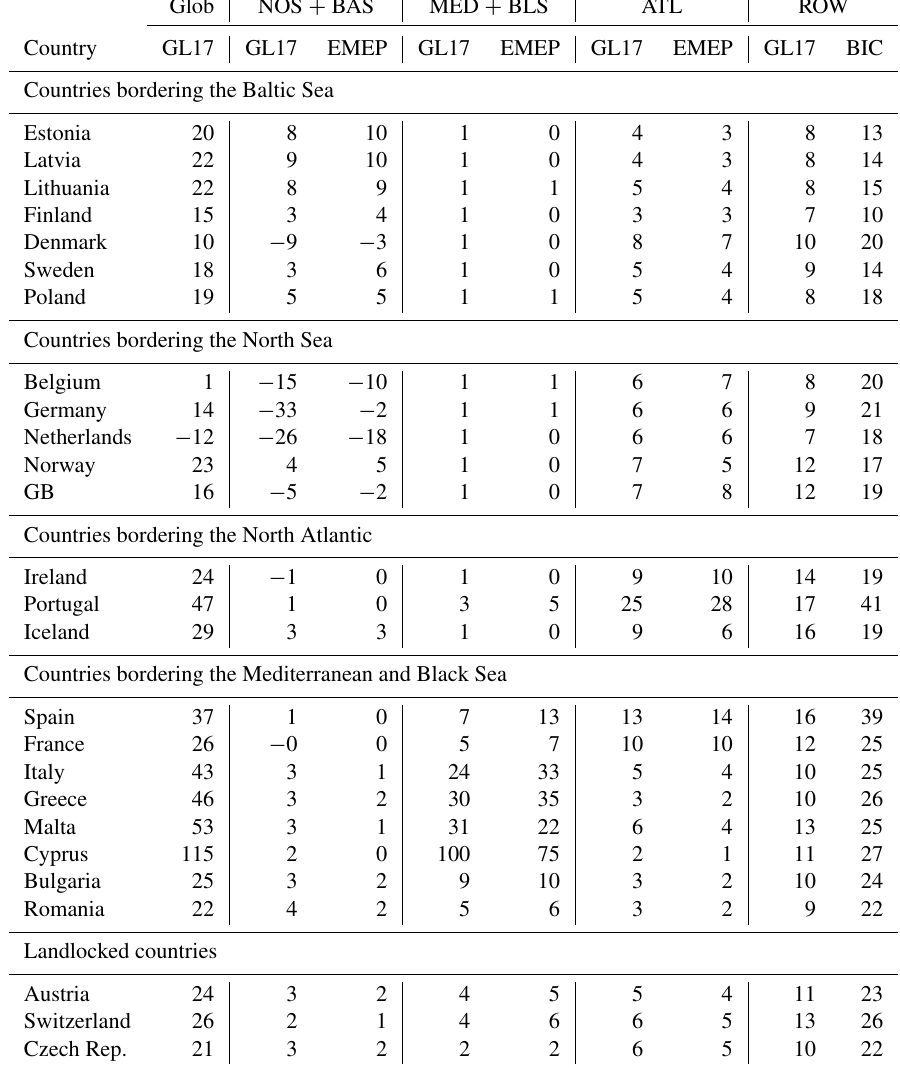
Table 4. Source receptor relationships for SOMO35 from shipping as calculated by the global model, GL17, without ShipNO x (see Sect. 2) and as reported in Appendix B in EMEP Status Report 1/2019 (2019). All the calculations are made with 2017 emissions and meteorological data. Glob is the contribution from all global shipping, NOS + BAS from the North Sea and Baltic Sea combined, MED + BLS from the Mediterranean Sea and Black Sea combined, and ATL from the north-east Atlantic. ROW includes the effects from all ship emissions outside the above-listed individual sea areas. BIC is regional boundary and initial concentrations (units: ppb · day per 15% emission